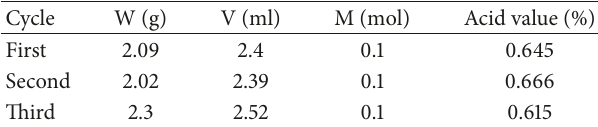
Table 1: Free Fatty Acid analysis results of crude karanja